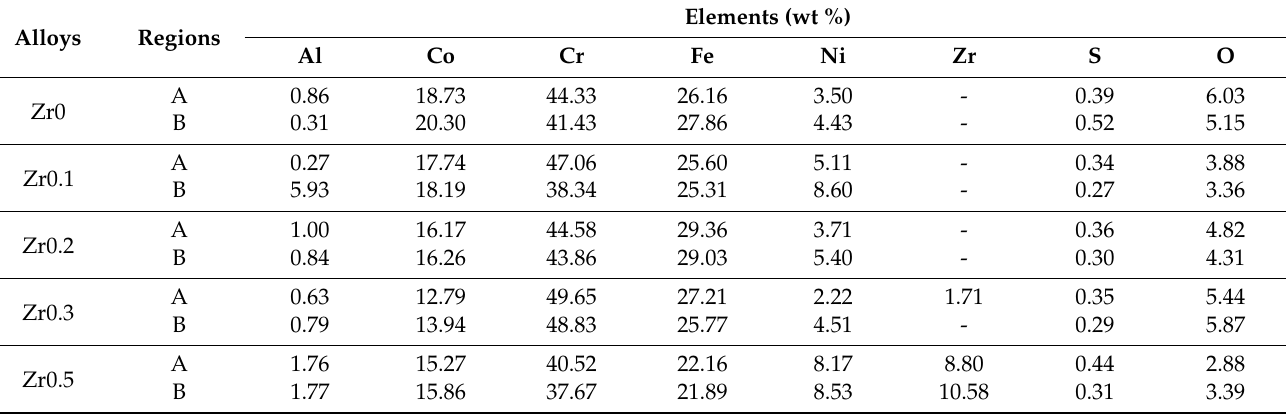
Table 3. EDS analyses for chemical compositions of the marked regions in the corroded surfaces of AlCoCrFeNiZr x ( x = 0.1, 0.2, 0.3, and 0.5) alloys (wt %). Alloys